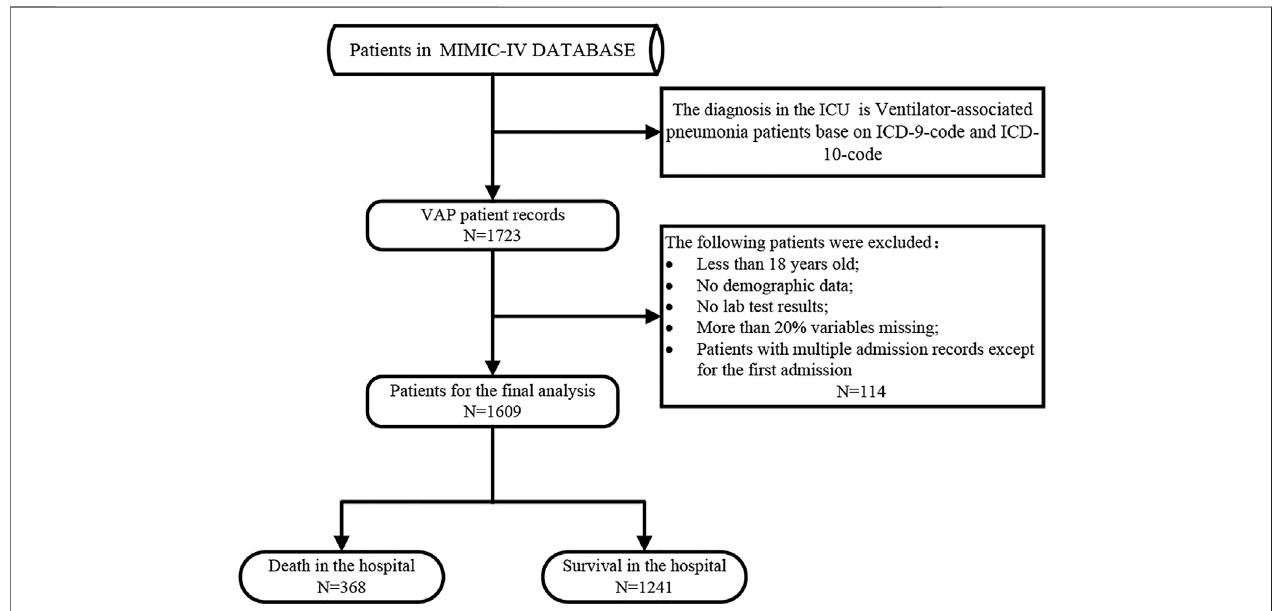
FIGURE 1 | Flow chat of study